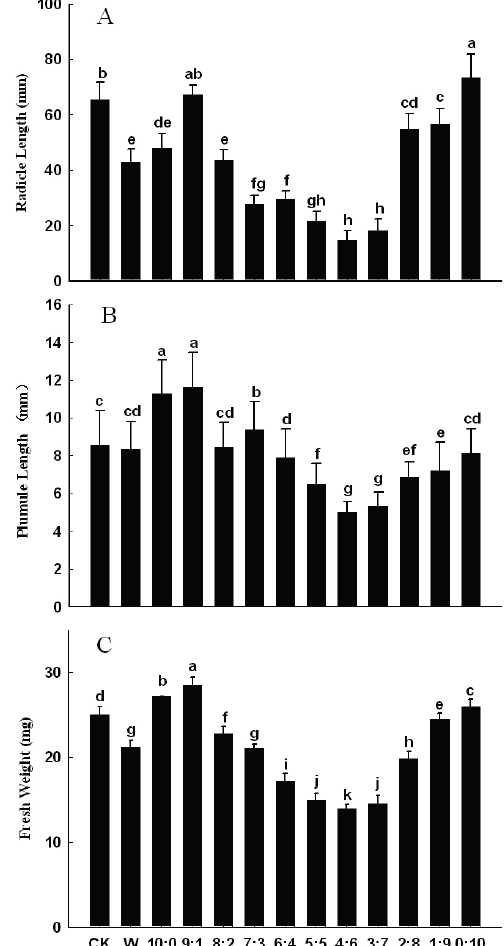
Figure 2. Effects of C. cathayensis exocarp extract and elution fractions on lettuce seedling growth: ( A ) radicle length; ( B ) plumule length; ( C ) fresh weight of seedling. Data are the mean ± SD values (n = 3 per group). Final means with different letters are significantly different at p =